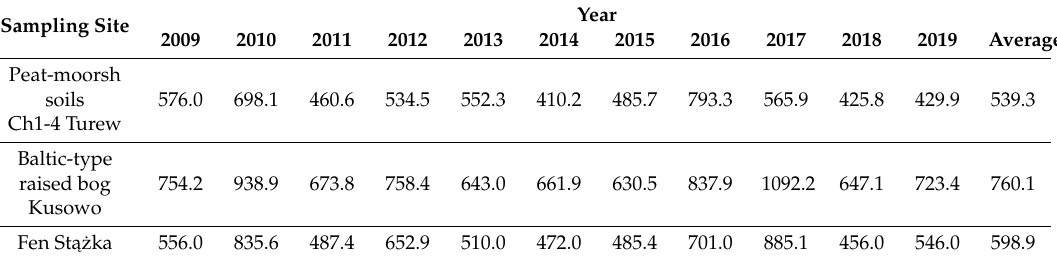
Table 2. Annual precipitation from 2009 to 2019 (mm).